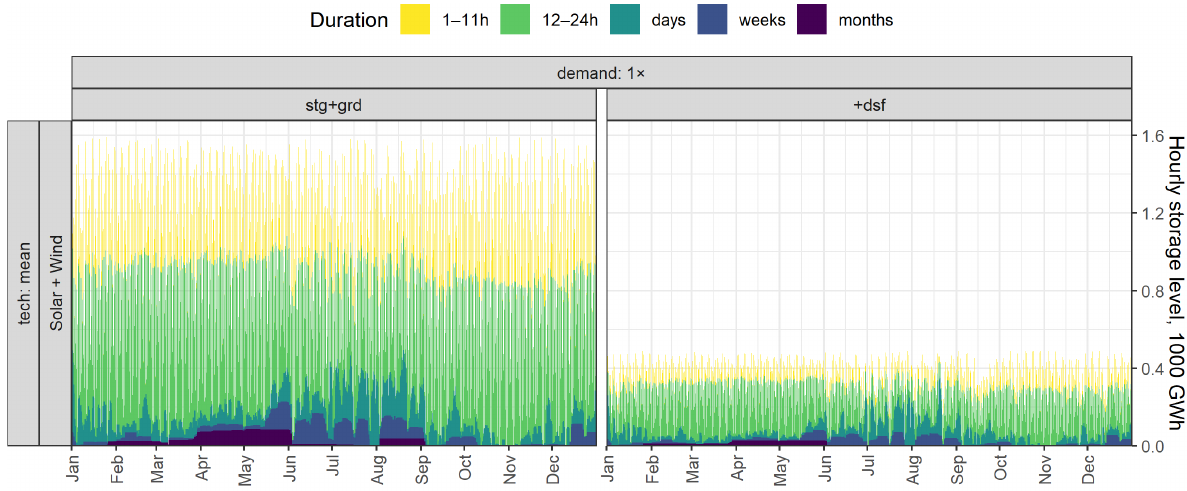
Figure A11. Estimated wind power supply curve with potential cumulative capacity by cluster, assuming 10% use of territory of each